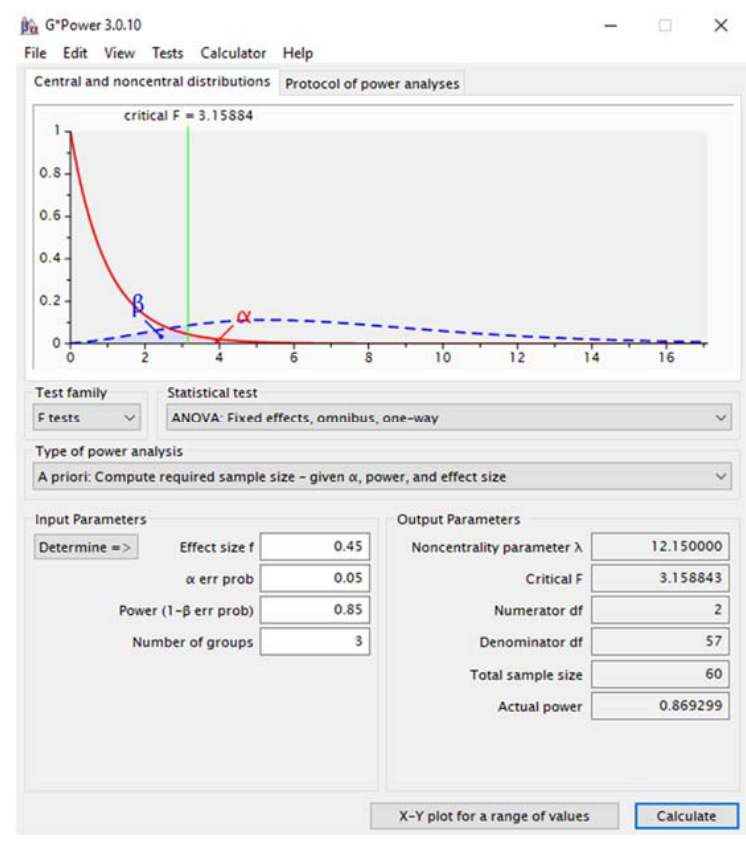
Figure 1. Sample size calculation.